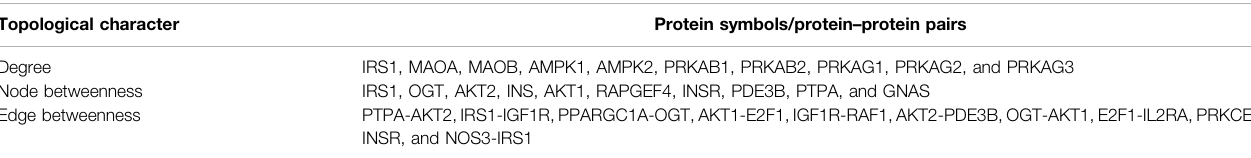
TABLE 2 | List of top 10 nodes and edges in the combined protein network. Topological character Protein symbols/protein – protein